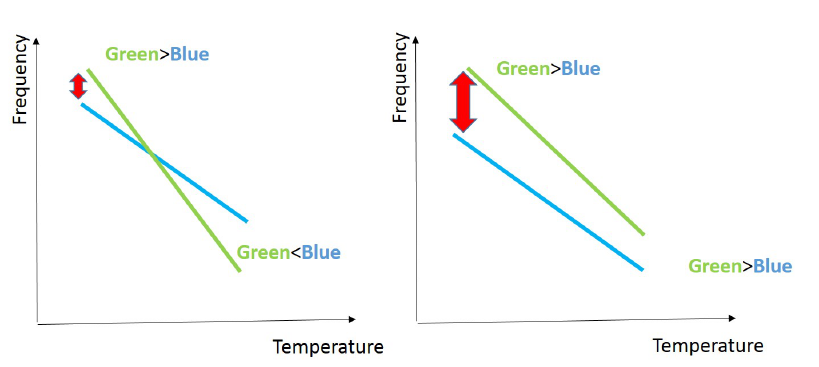
Figure 6. Bit flip due to temperature variation in unstable pairs. Adapted from [45].